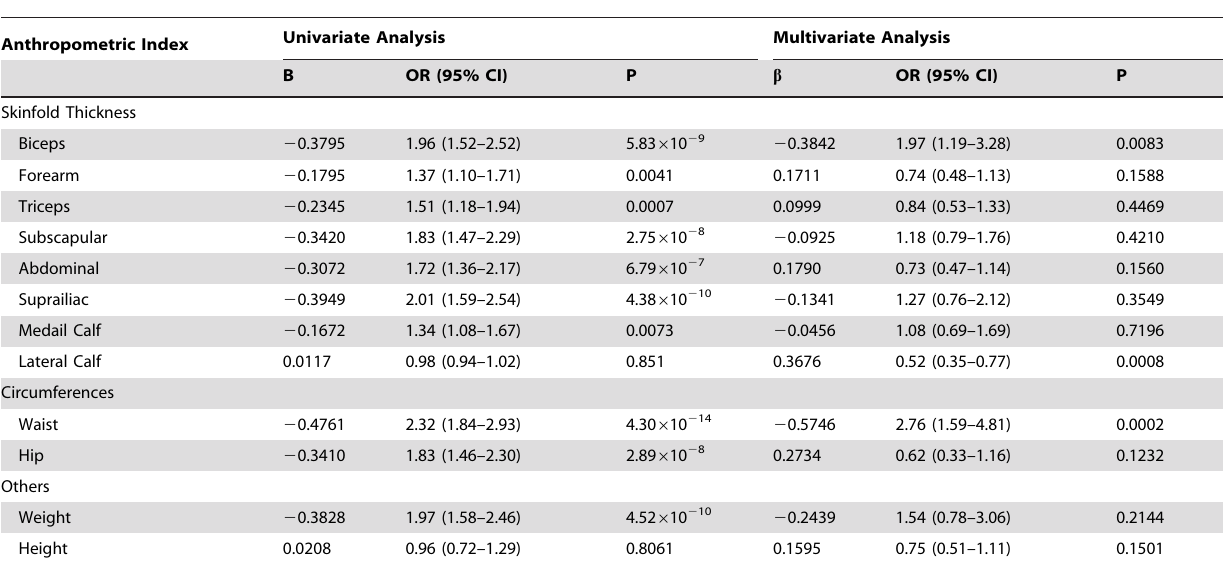
Table 1. Univariate and multivariate association of anthropometric indexes with cumulative risk of T2D.